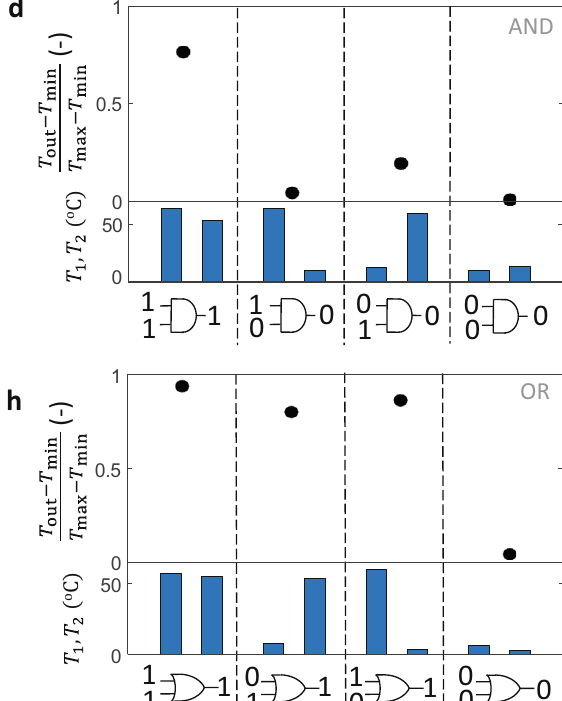
Figure 6c is an optical image of our fabricated thermal AND gate.